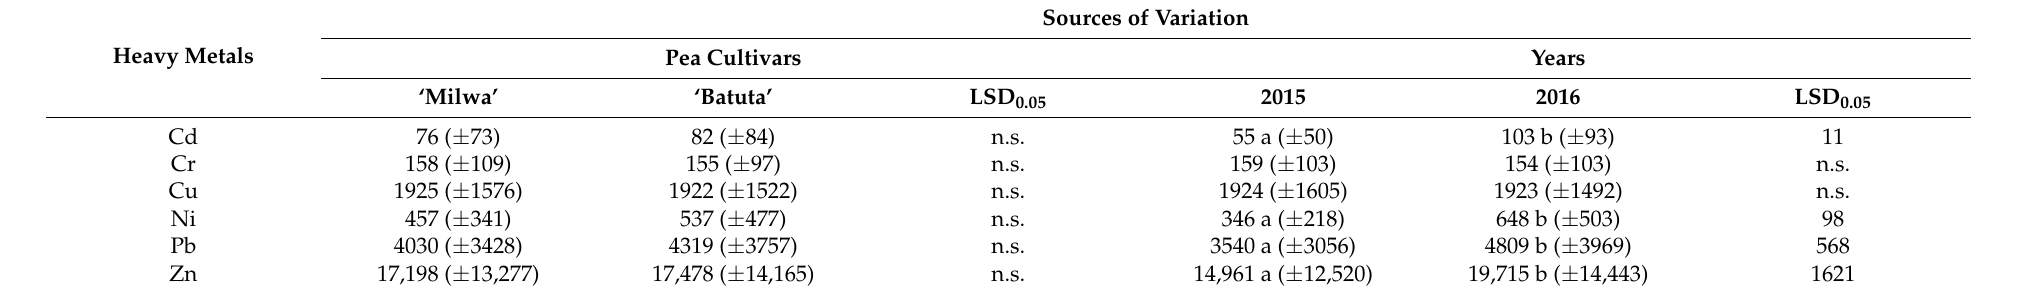
Table 8. HMD up by entire pea plants, mg · ha − 1 . (mean values ± SD of six growth stages, two successive years or two cultivars, respectively, and with three repetitions